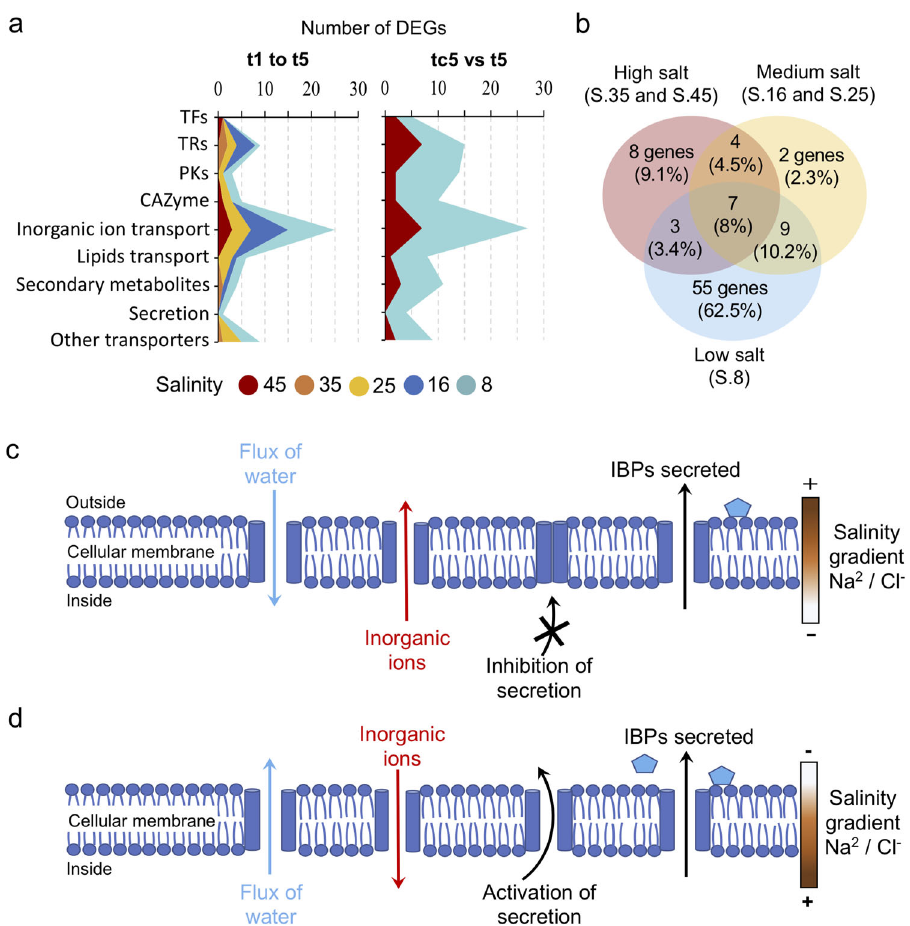
Fig. 6 Comparison of the nine selected pathways and potential actions of this pelagophyte strategy to tolerate salinity fl uctuations. a Number of differentially expressed genes (DEGs) overexpressed at each time of sampling (t1 to t5) for progressive decreased salinity change and between tc5 – S.45 (control) and t5 – S.8 among the different categories. b Venn diagram shows how many functions from all categories mentioned above that were shared and unique between high (group of S.35 and S.45), medium (S.16 and S.25) and low salinity (S.8). The potential strategy of pelagophyte when exposed at ( c ) high and ( d ) low salt. Blue pentagon symbol represents ice-binding protein (IBP). TFs transcription factors, TRs transcription regulators, PKs protein kinases, CAZYmes carbohydrate-active